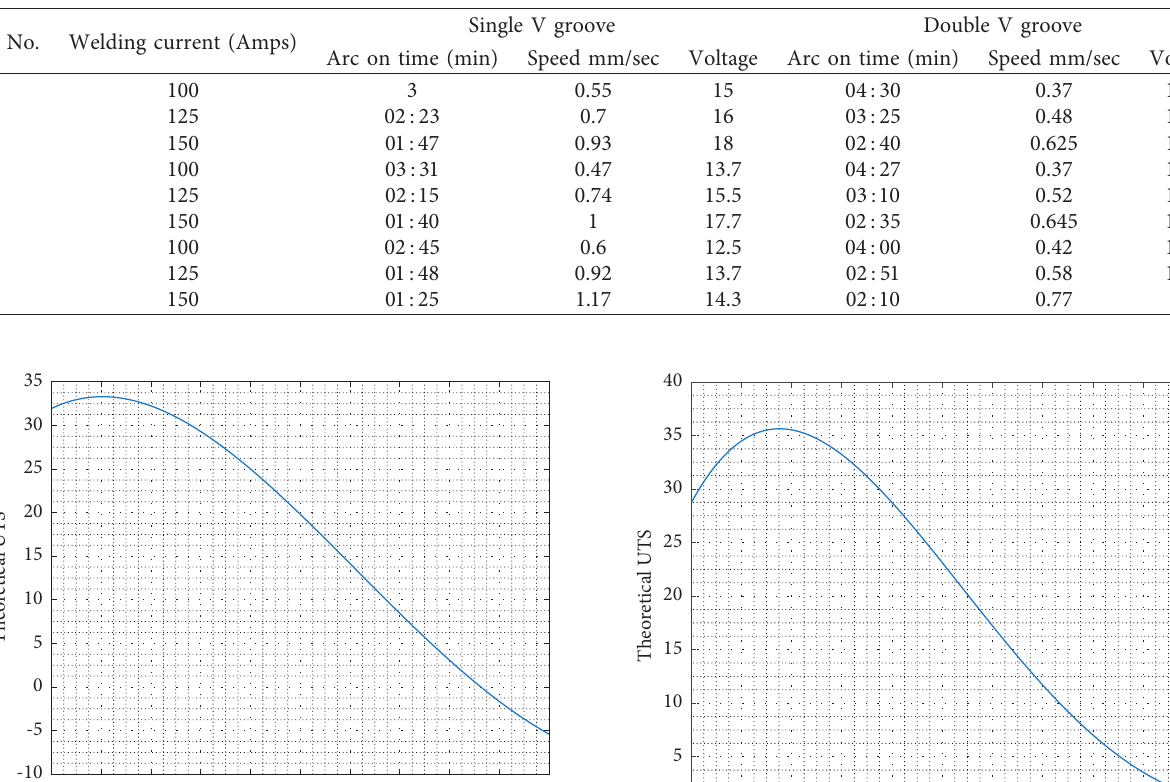
Table 9: Weld speed calculation.